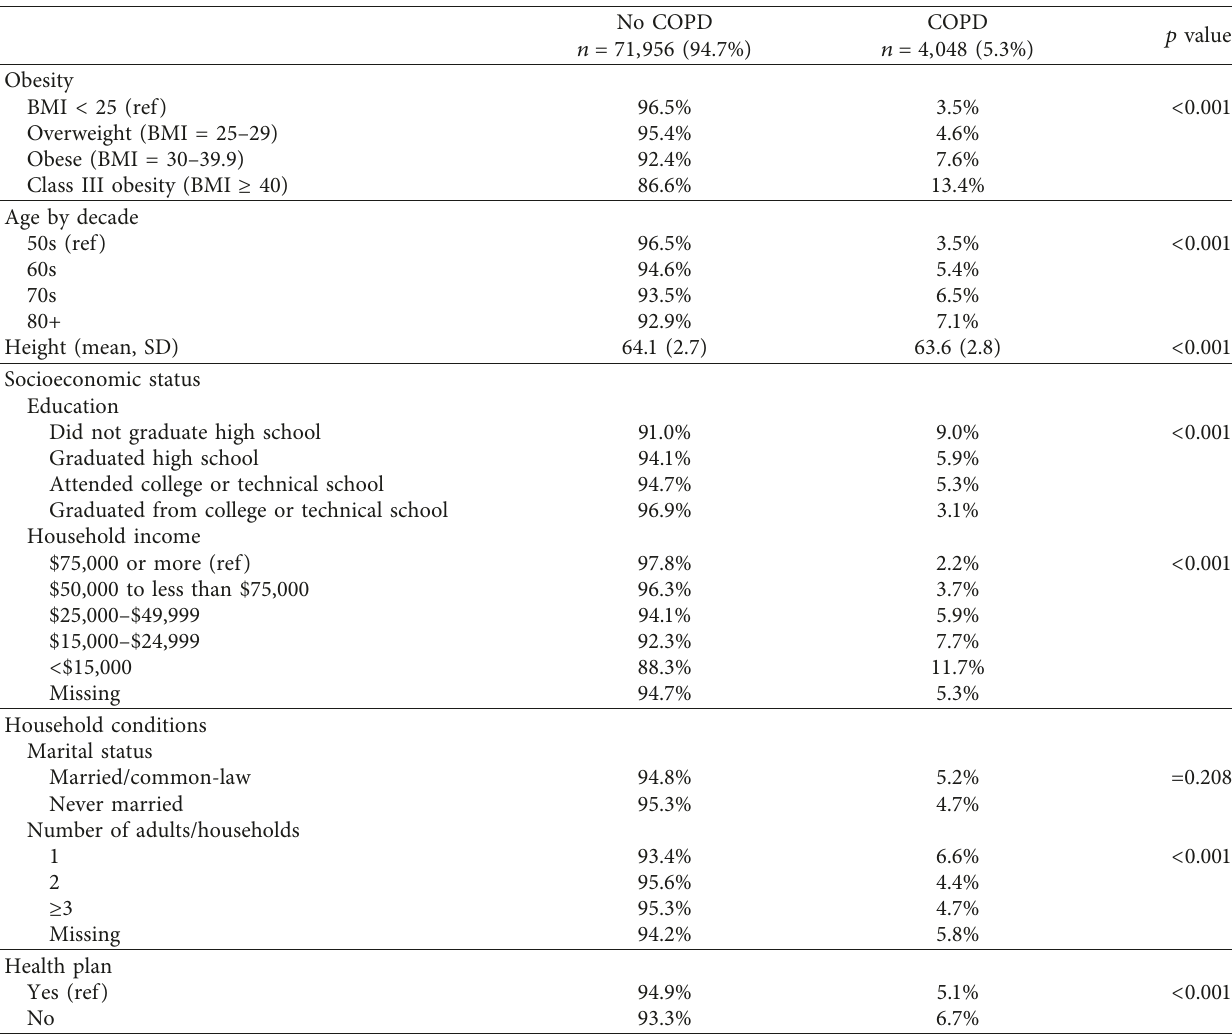
Table 1: Prevalence of COPD by Obesity Level and other Characteristics among non-Hispanic white older women (aged 50+) who had never smoked ( n � 76 , 004) 1